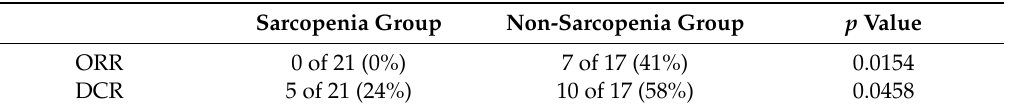
Table 2. Overall response rate (ORR) and disease control rate (DCR) in the sarcopenia and non-sarcopenia groups.